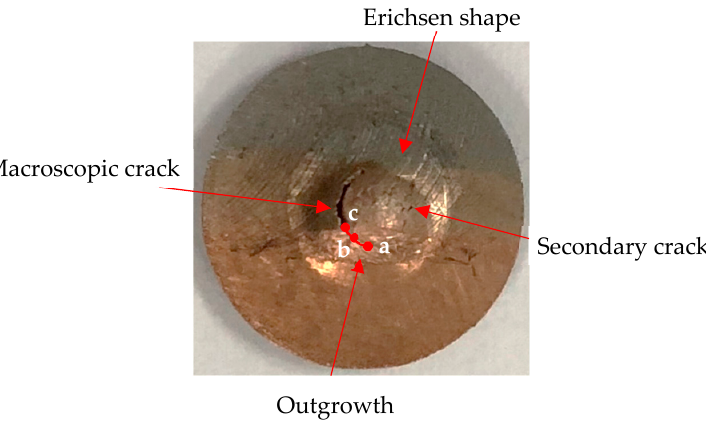
Figure 9. The macromorphology fracture of the SPT specimen: ( a ) the initiation region, ( b ) the middle area, ( c ) the initial crack region.